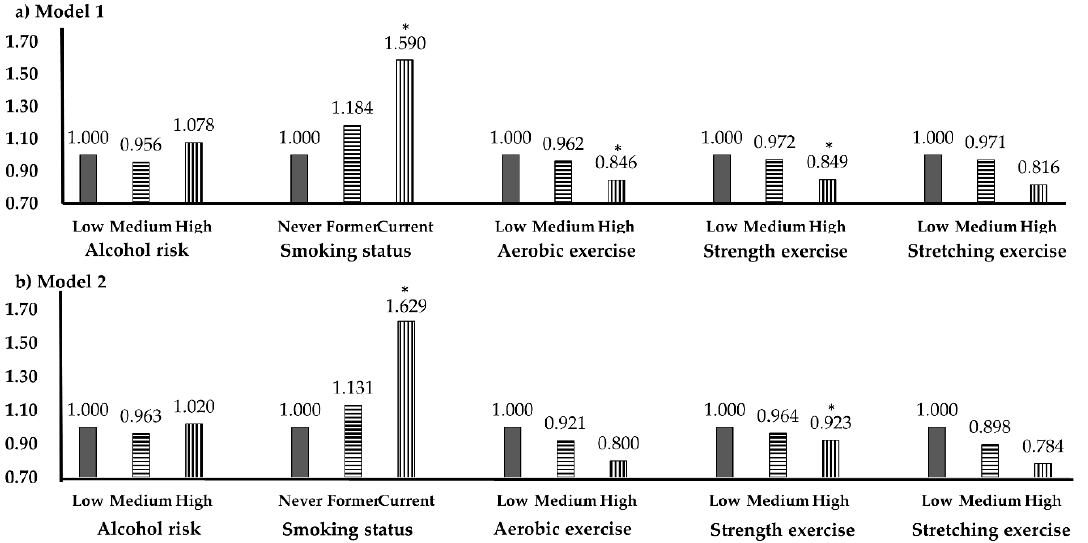
Figure 2. Low testosterone prevalence according to health behavior. * p < 0.05; OR, odds ratio; CI, confidence interval. ( a ) Model 1, adjusted variable is age. ( b ) Model 2, adjusted variables are age, waist circumference, smoking.